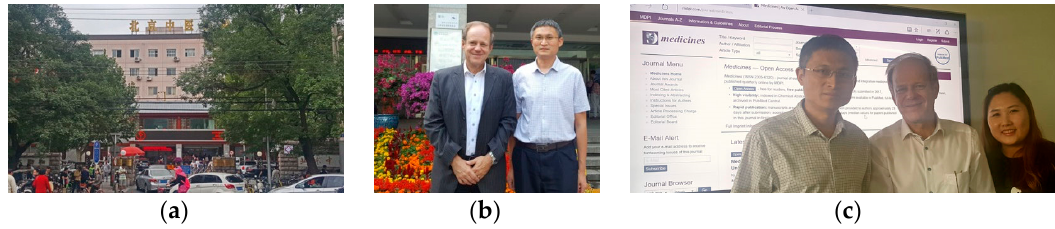
Figure 23. ( a ) Beijing Hospital of TCM affiliated to CMU; ( b ) Professor Gerhard Litscher (left) and